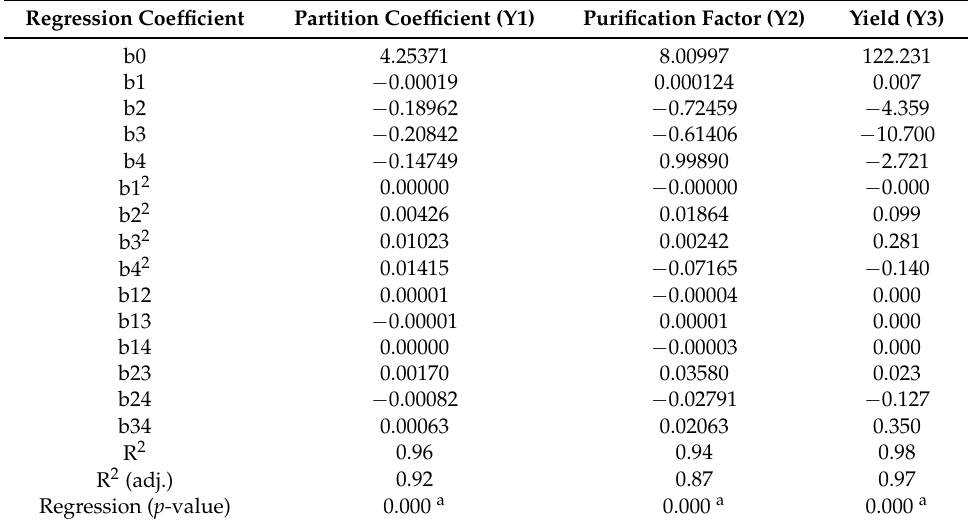
Table 1. Regression coefficients, R 2 , adjusted R 2 and probability value of the response surface